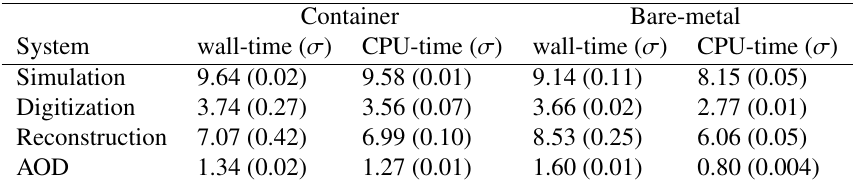
Table 2. Timing comparison for MC workflows (times in